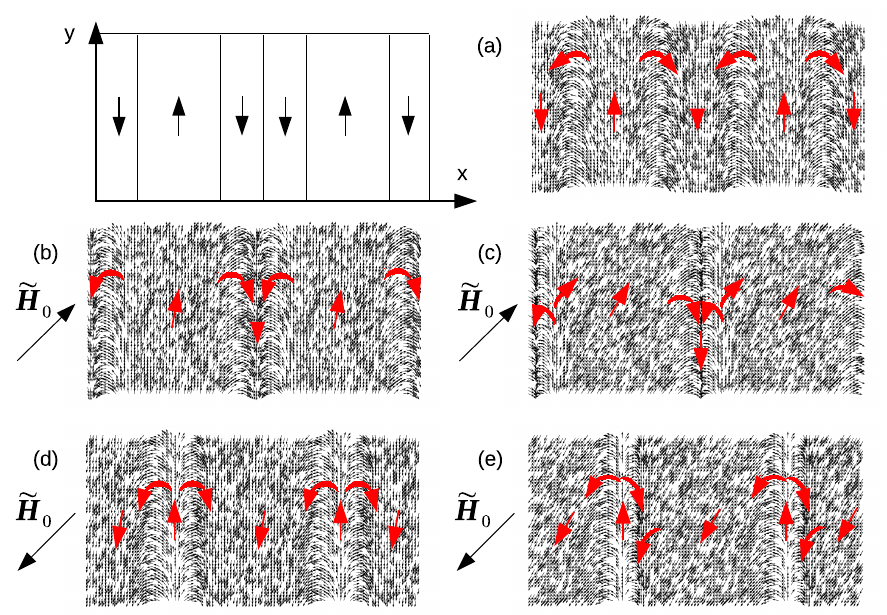
Figure 4. Distribution of the magnetization vector m in a magnetic field applied at an angle 45 ◦ to the x and y axes: ( a )— ˜ H 0 = 0, ( b )— ˜ H 0 = 0.4, ( c )— ˜ H 0 = 2, ( d )— ˜ H 0 =